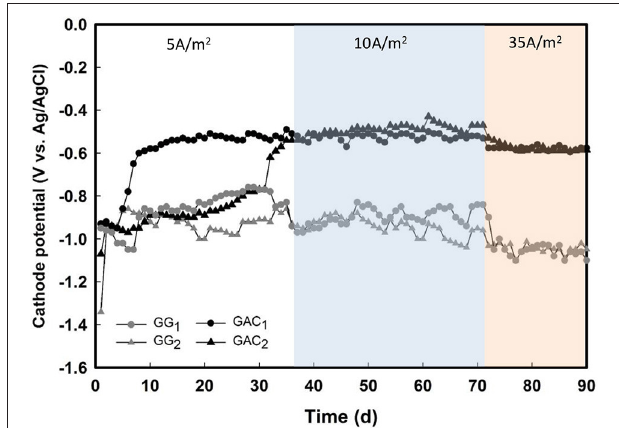
FIGURE 6 | Taxonomic distribution of microbial populations with > 2% relative abundance by 16S rRNA gene sequences. Samples from all four reactors were taken from: (A) biofilm on granular biocathodes (GAC 1 -E, GAC 2 -E, GG 1 -E, GG 2 -E); (B) suspended cells within the catholyte (GAC 1 -S, GAC 2 -S, GG 1 -S, GG 2 -S).